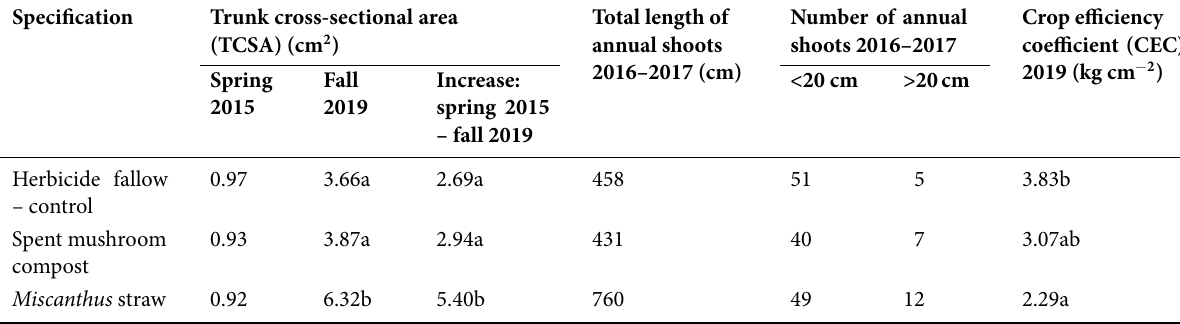
T able 6 Growth and crop efficiency coefficient of apple trees under the three assessed orchard floor management treatments for the years 2016 to